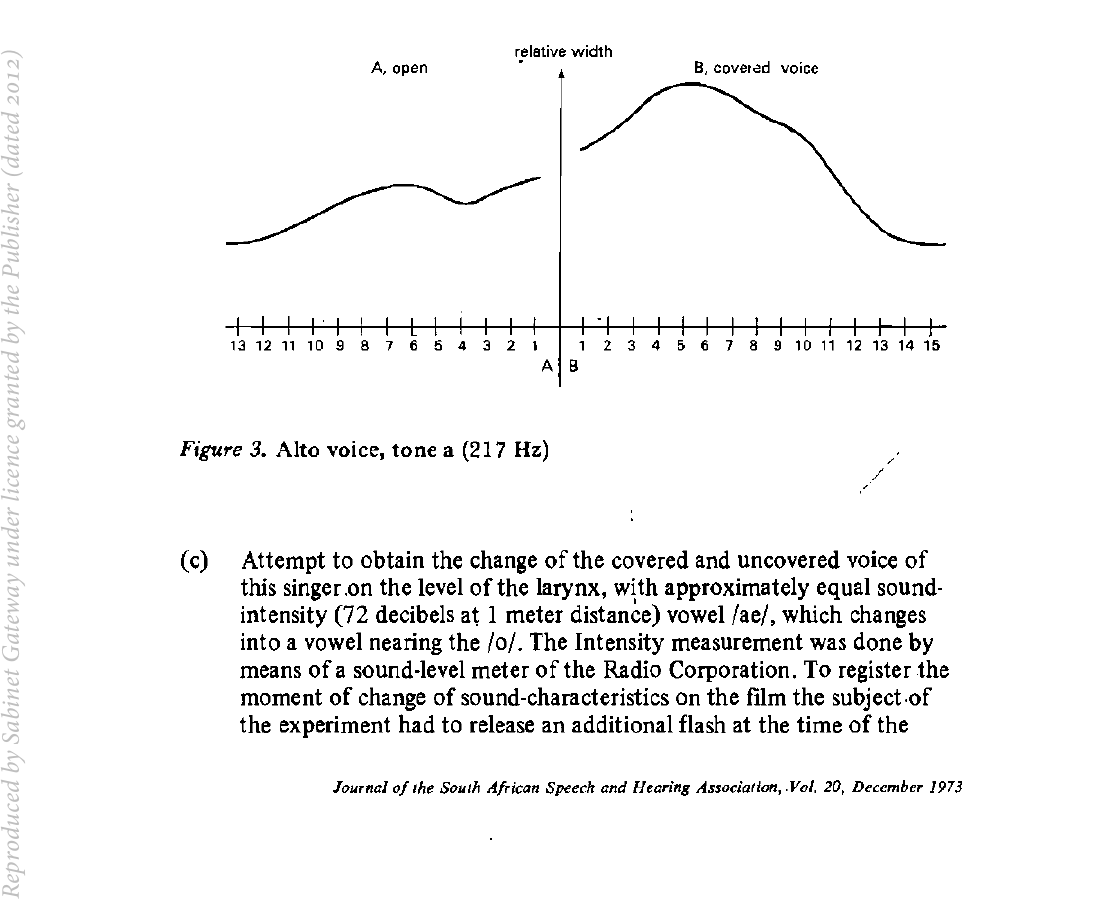
Figure 2. Alto Voice. (Transitions: dotted lines — covered voice, dark lines — uncovered voice.)